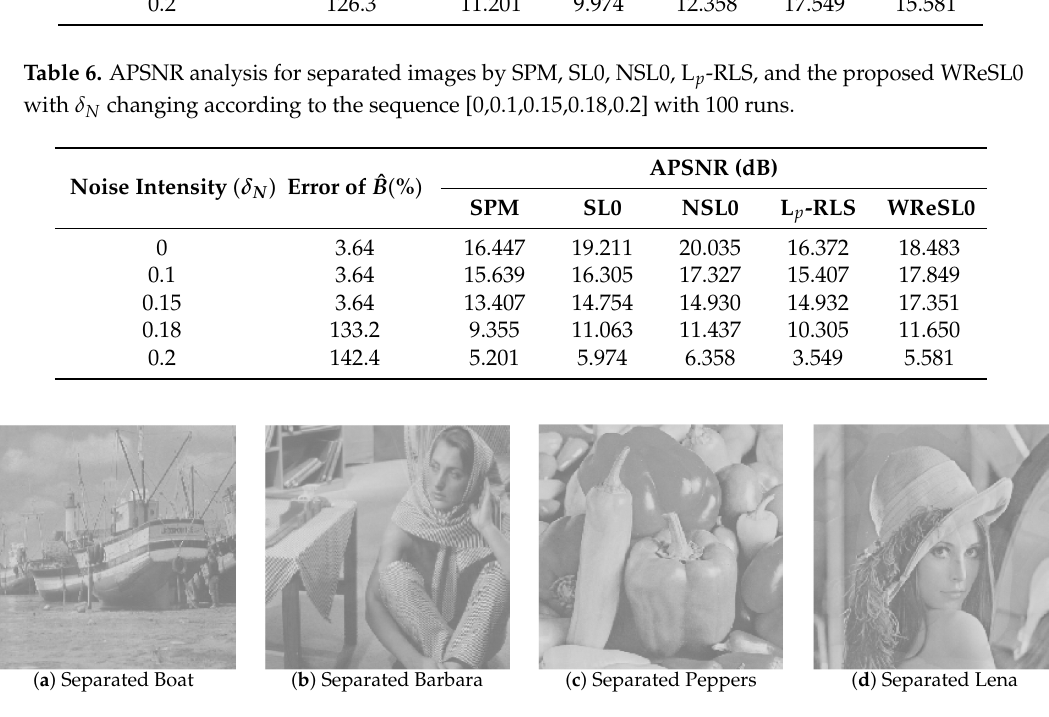
Figure 18. Separated images: ( a ) boat; ( b ) Barbara; ( c ) peppers; ( d )